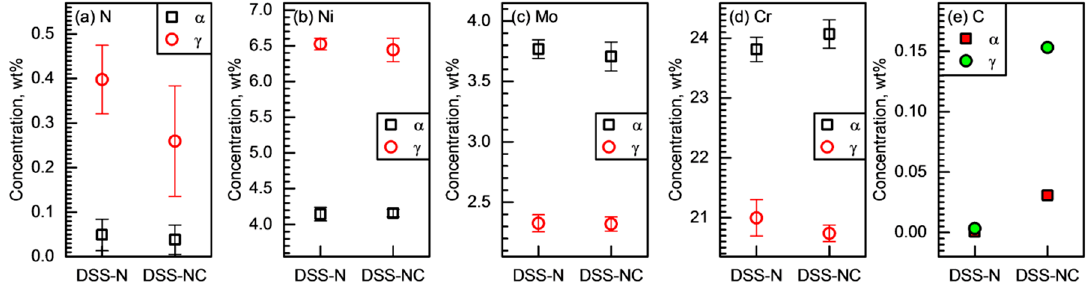
Figure 5. Chemical compositions of ( a ) N, ( b ) Ni, ( c ) Mo, and ( d ) Cr of the α and γ phases in the DSS-N and DSS-NC measured using the EPMA. For each phase of each DSS, 10 points were analyzed using an EPMA, and the averages and the standard deviation values (scatter band) were calculated. ( e ) C contents of the α and γ phases of the DSSs calculated by Thermo-Calc software.